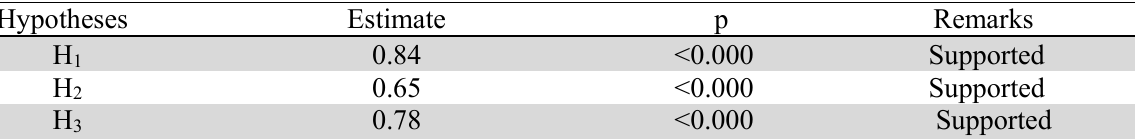
Standardized path